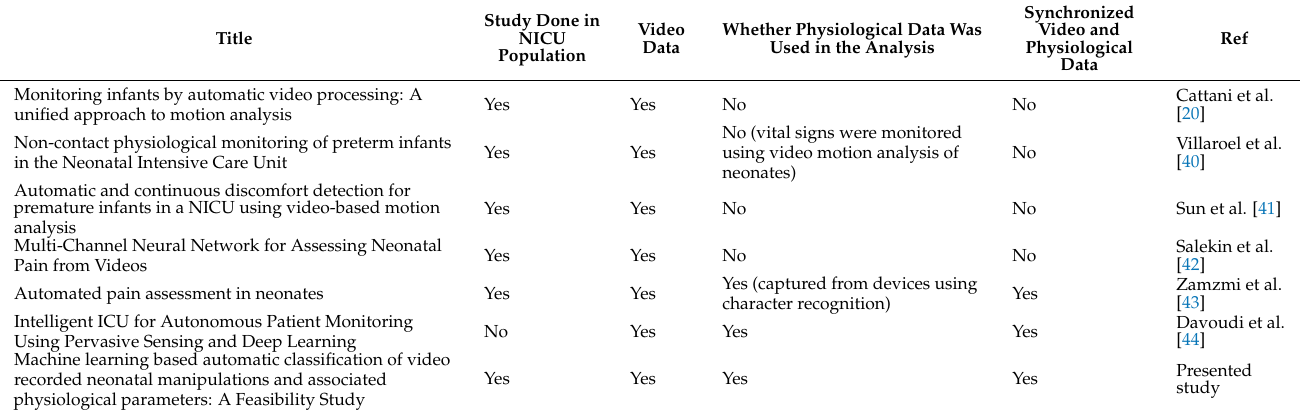
Table A1. Comparison table of different studies.